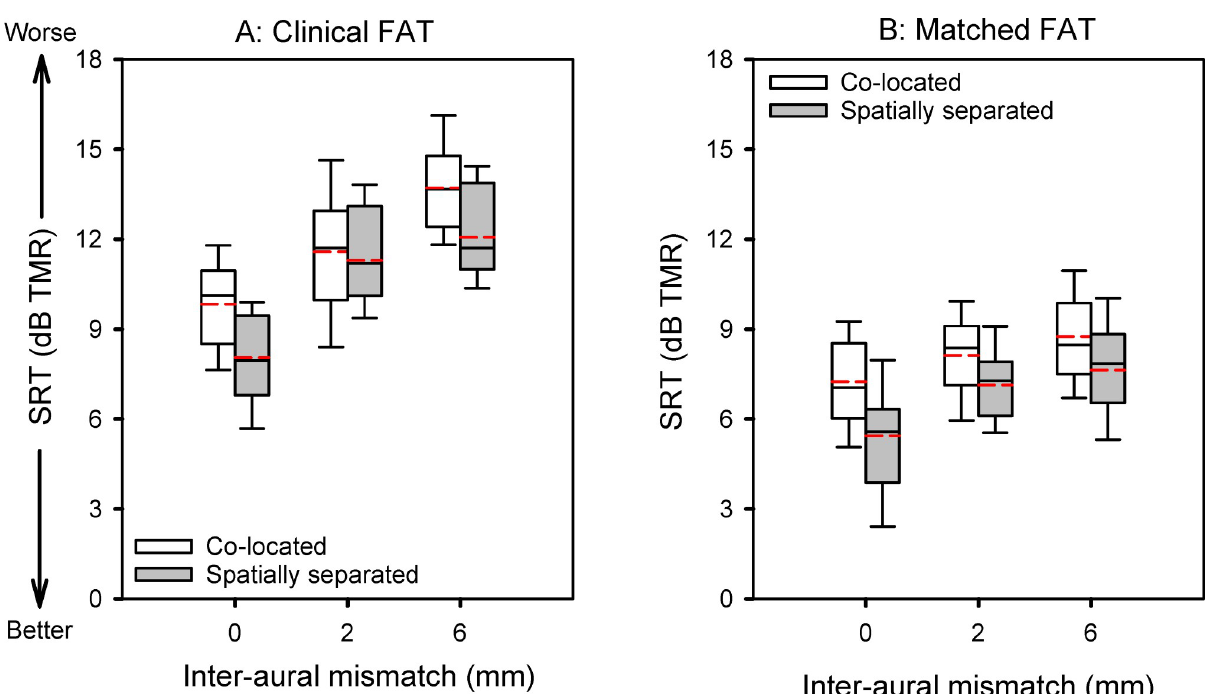
Fig 2. SRTs with the clinical FAT (Panel A) and matched FAT (Panel B), and with co-located or spatially separated target and masker speech, as a function of inter-aural mismatch. The boxes show the 25 th and 75 th percentiles, the error bars show the 10 th and 90 th percentiles, the symbols represent outliers, the solid horizontal line shows the median, and the dashed red line shows the